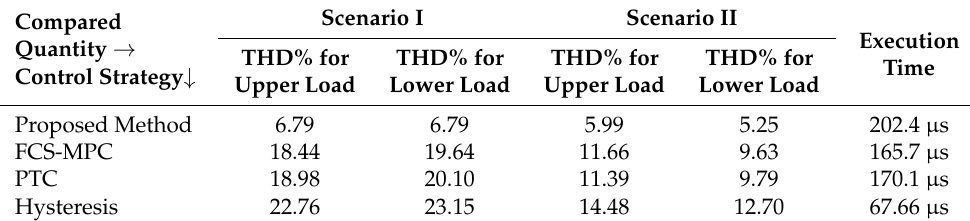
Table 3. Comparison results between different control